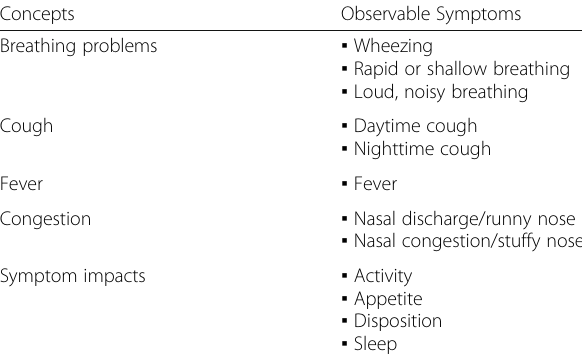
Table 4 Respiratory Syncytial Virus Infection: Concept List